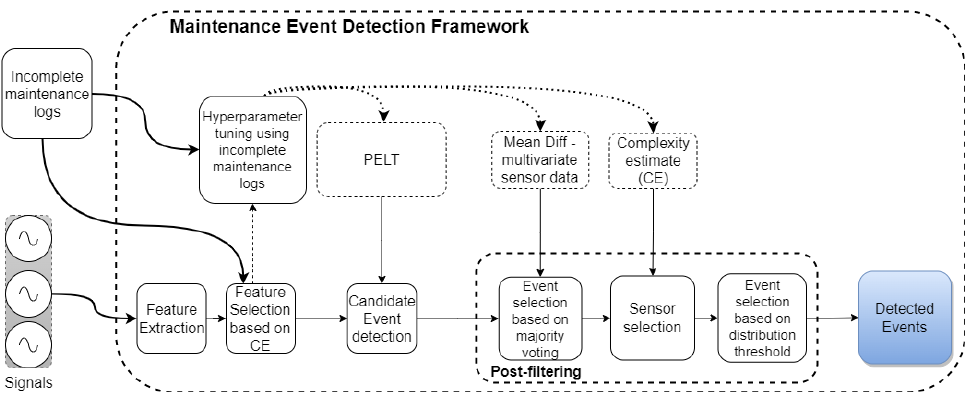
Figure 1. Maintenance event detection framework. Consisting of the following steps: Feature extraction and feature selection based on complexity estimate (CE), hyper-parameter tuning using partly maintenance logs, initial event detection based on the PELT, and post-filtering (mean and distribution analysis) to reduce FP